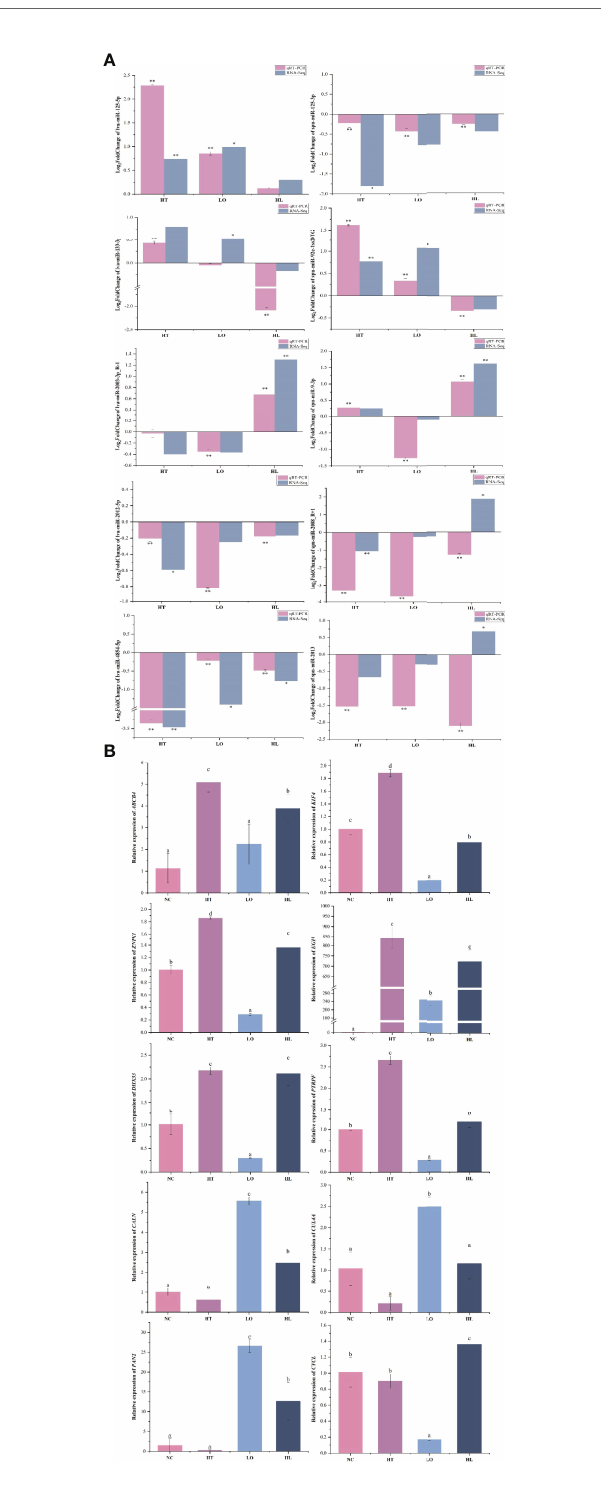
FIGURE 7 | qRT-PCR veri fi cation of DEMs (A) and target DEGs (B) . Each vertical bar represents the Mean ± SD (n=3), U6 and18s rRNA were used as a reference miRNA/gene. *Signi fi cant differences at P <0.05 vs control (NT). **Highly signi fi cant differences at P <0.01 vs control (NT). Letters above the bars indicate signi fi cant differences at P